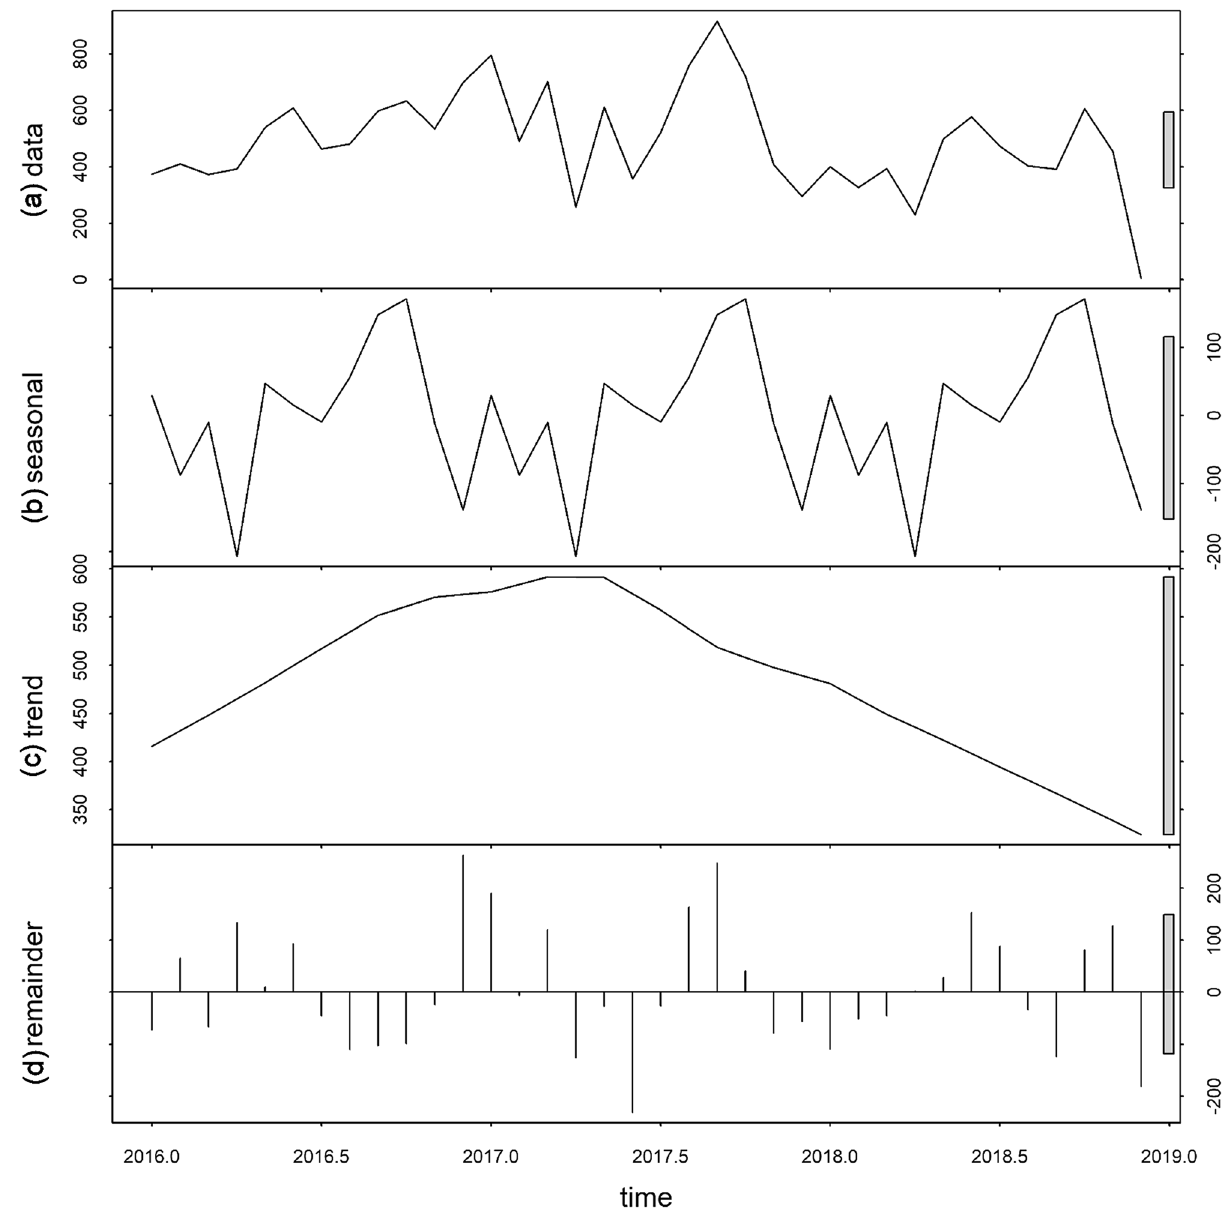
Figure 3. Temporal decomposition of imported malaria in Bolivar, Venezuela, 2016–2018. (a) The original time series, (b) the decomposed components, denoting the seasonal component, (c) long-term trend component and (d) remainder